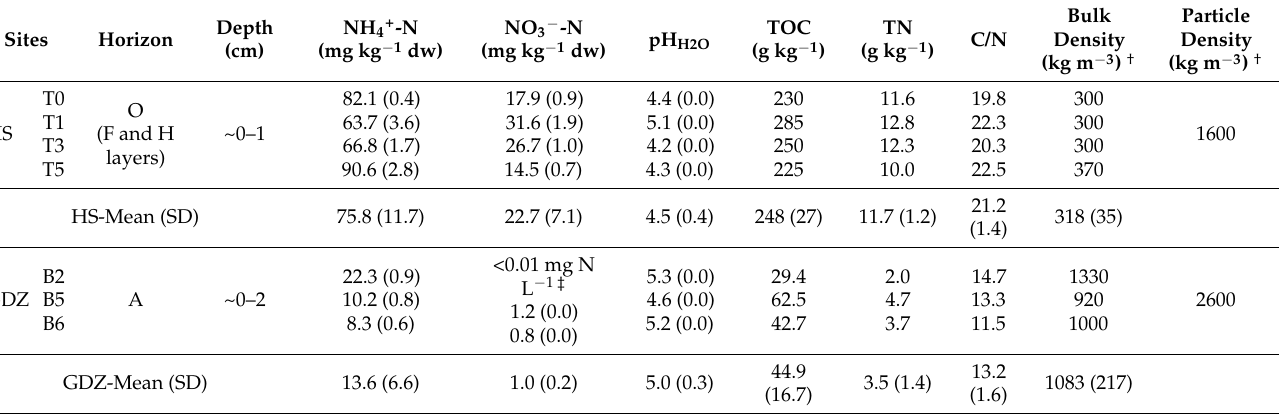
standard deviations ( n =